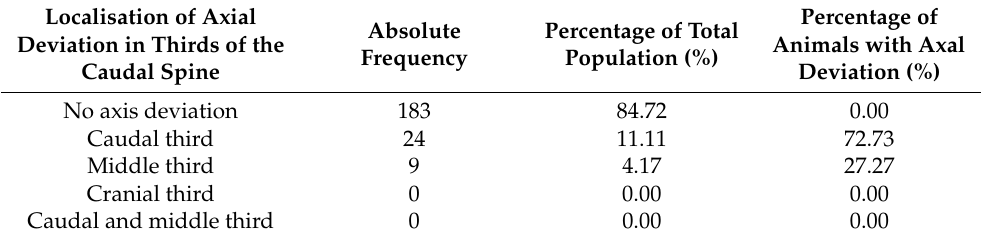
Table 4. Frequency and localisation of axial deviations within the caudal spine of